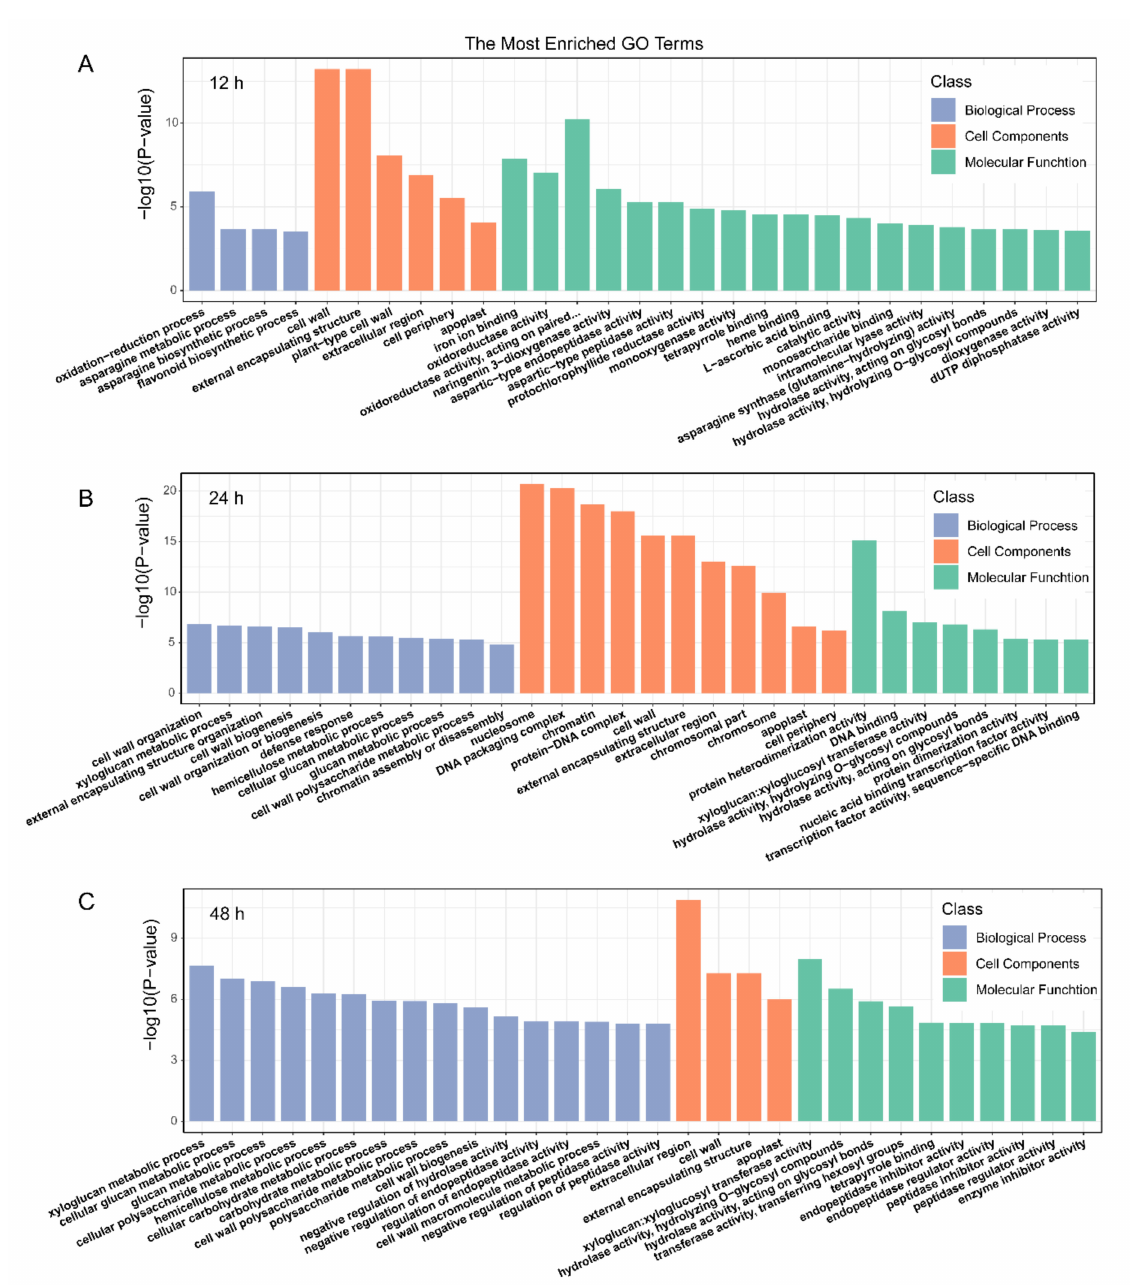
Figure 5. GO enrichment analysis of DEGs detected after treatment of leaves for 12 h ( A ), 24 h ( B ), and 48 h ( C ). The Top 30 GO terms with the most significant enrichment level are displayed in the order of p -value from small to